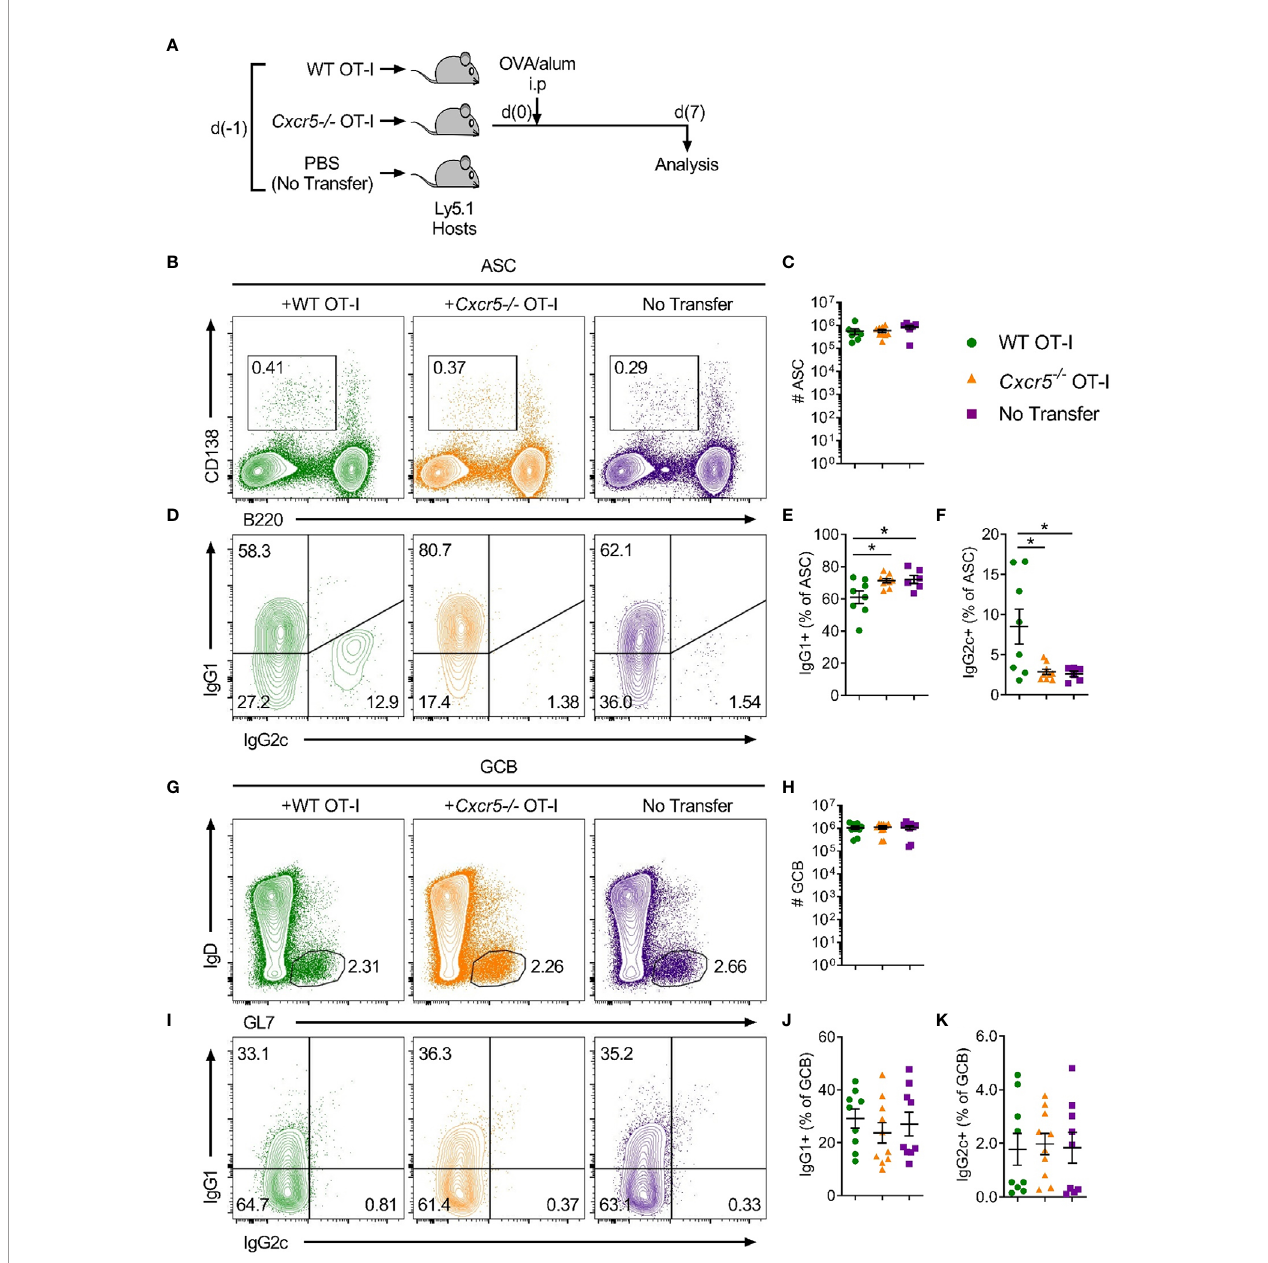
FIGURE 3 | CD8 + T cells require CXCR5 expression to skew class switching from IgG1 to IgG2c in ASCs in response to OVA/alum. Congenically marked WT (CD45.1/2) or Cxcr5 -/- (CD45.2) OT-I cells (or PBS only for no transfer controls) were transferred i.v into separate B6.Ly5.1 (CD45.1) mice that were subsequently immunised with OVA/alum i.p. and harvested on day 7 post-immunisation for analysis. (A) Schematic outline of the experiment. (B) Gating strategy used for identi fi cation of CD138 + B220 int ASCs in spleens. Pre-gated on live, single cells. (C) Total number of ASCs. (D) Analysis of intracellular IgG1 and IgG2c in IgM - ASCs. (E, F) Frequency of (E) IgG1 + and (F) IgG2c + ASCs among total ASCs. (G) Gating strategy used for identi fi cation of B220 + IgD - GL7 + GCB cells in spleens. Pre-gated on live, single, B220 + CD138 - cells. (H) Total number of GCB cells. (I) Analysis of intracellular IgG1 and IgG2c in total GCB cells. (J, K) Frequency of (J) IgG1 + and (K) IgG2c + GCB cells among total GCB cells. (C, E, F, H, J, K) Data are pooled from two independent experiments with a total of 6-10 mice per group. Data were analysed by ordinary one-way ANOVA. Mean ± SEM. *p <